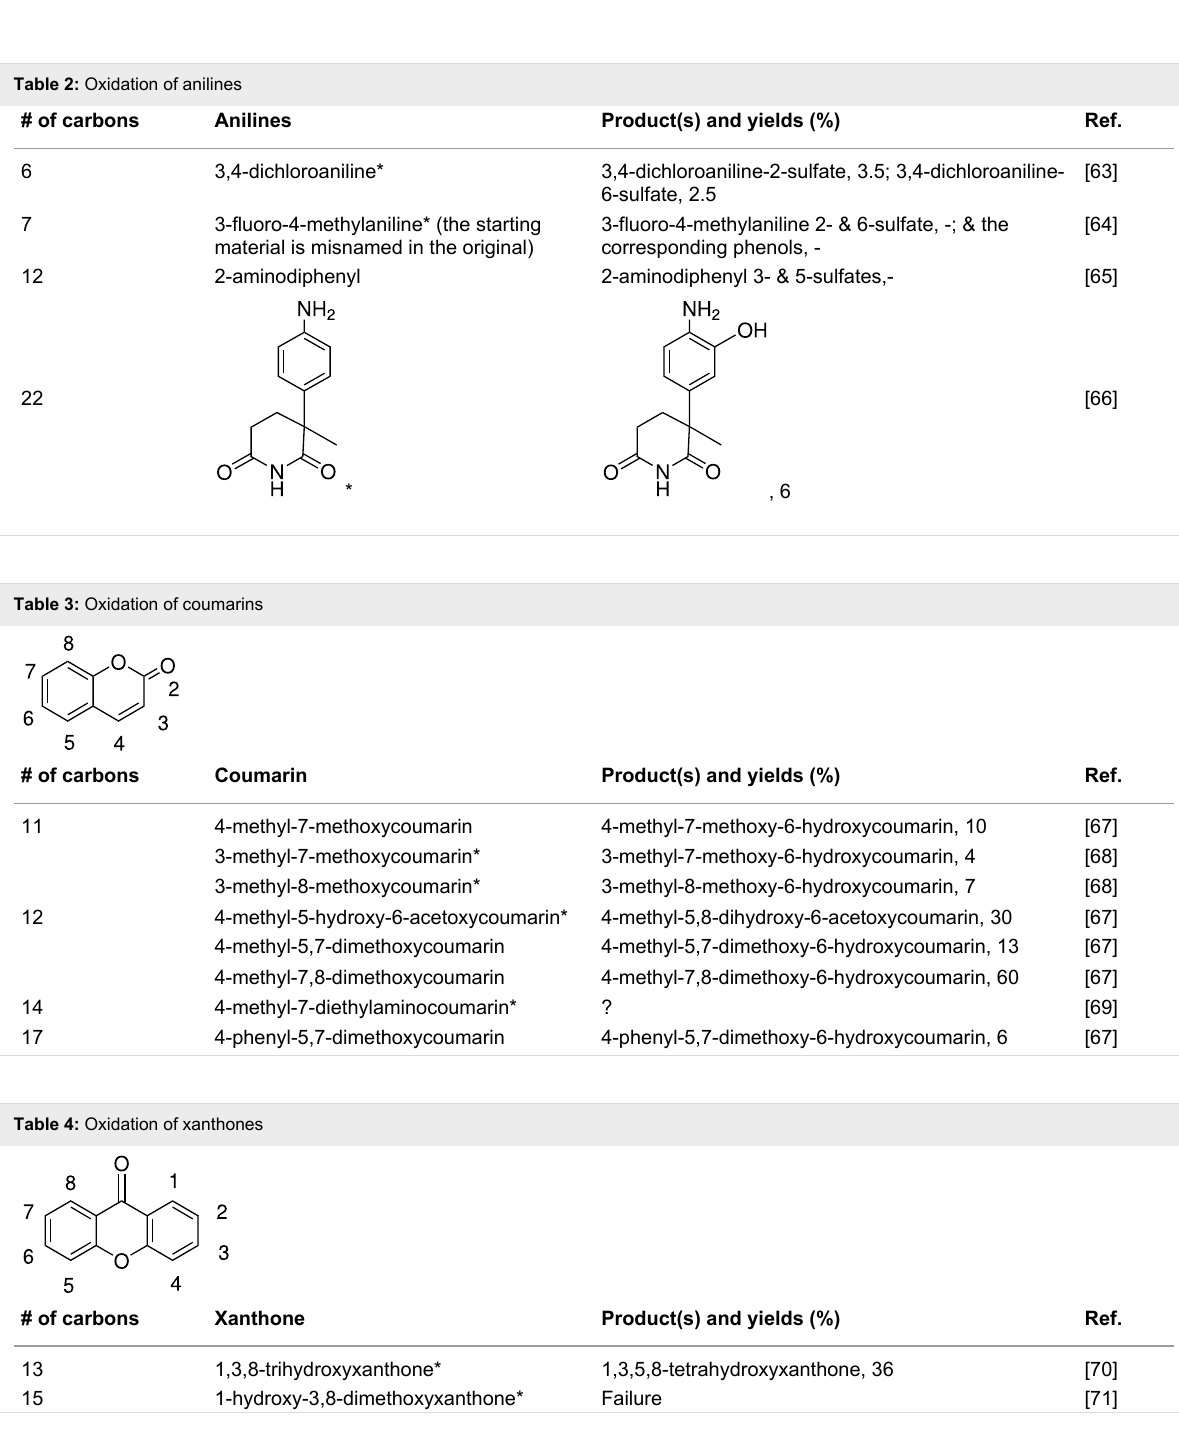
# of carbons Product(s) and yields